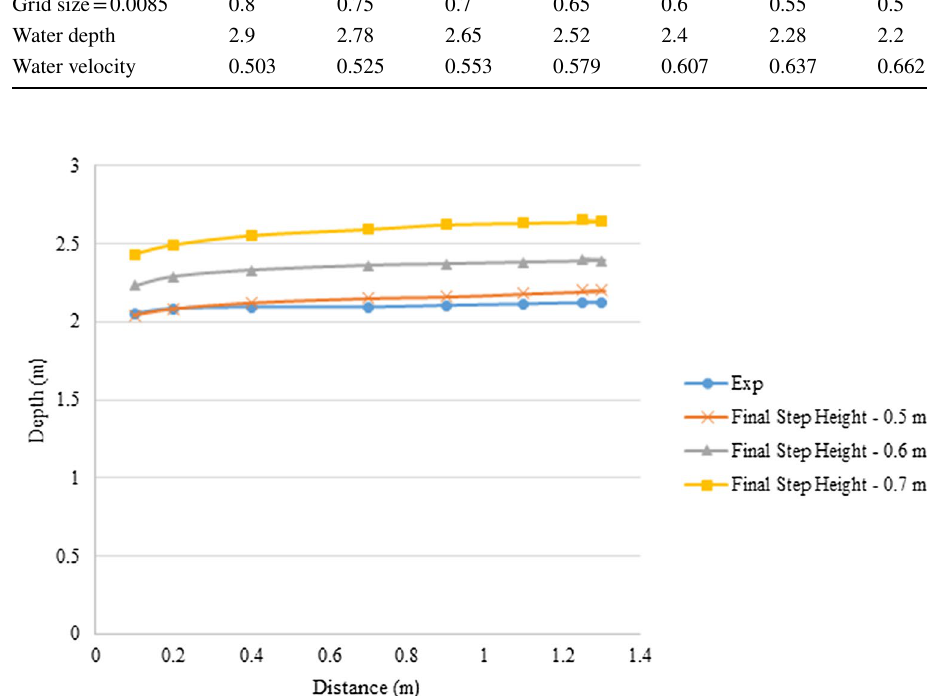
Table 4 The effect of changing the height of the step on the flow parameters in section 2